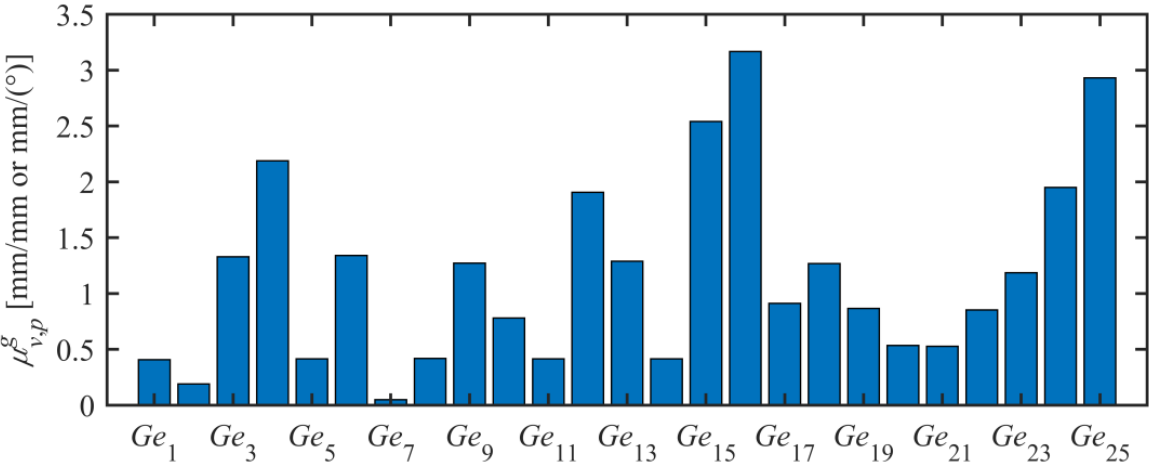
Figure 9. Global sensitivity of the average linear comprehensive deformation with respect to Ge p s.